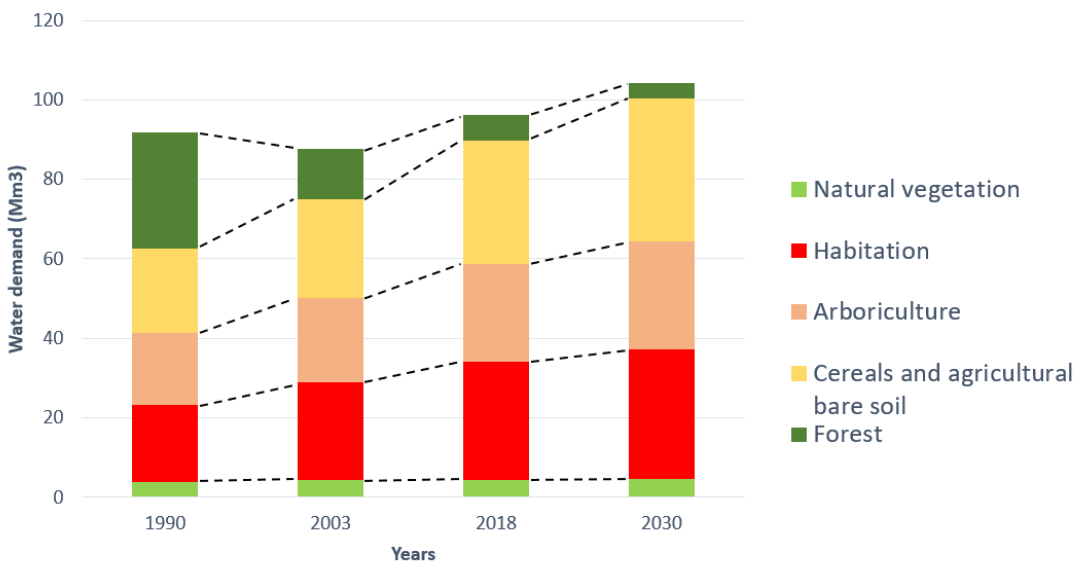
Figure 7. Water demand for different classes.